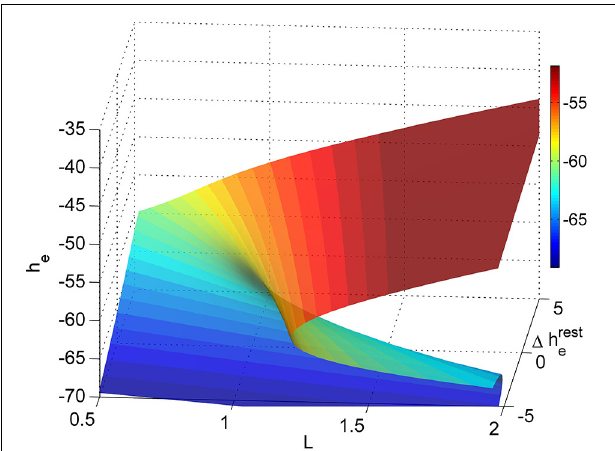
FIGURE 2 | Sleep-manifold showing the folding state-space surface (folded area is bi-stable) over a two dimensional parameter space (adapted from Dadok et al.,